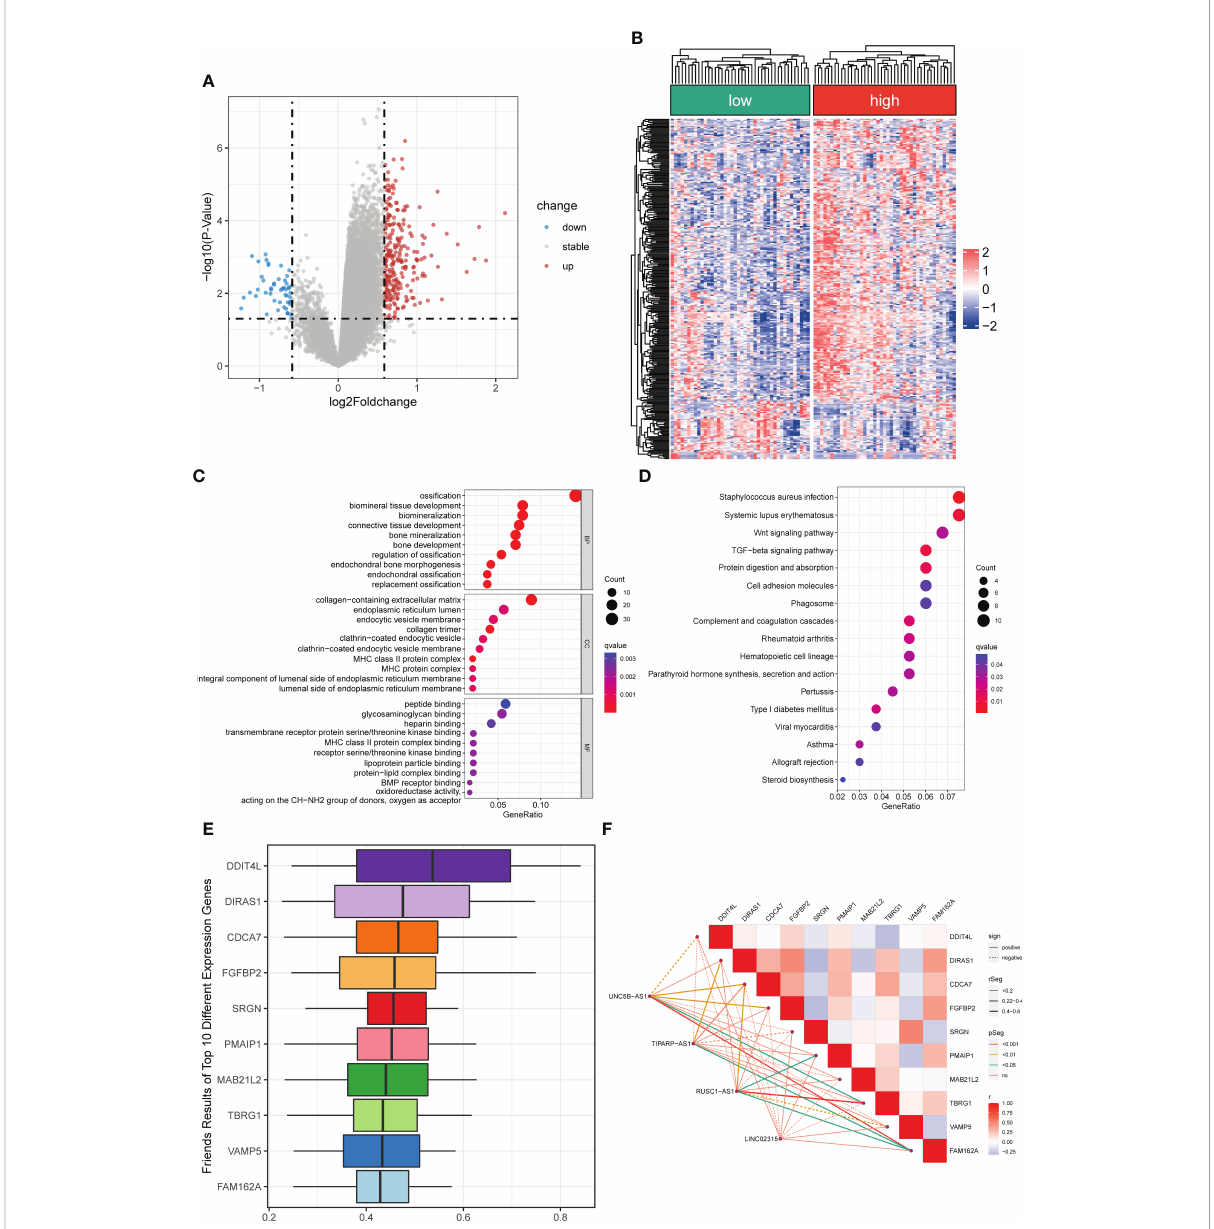
FIGURE 5 Differentially expressed and functional enrichment analysis between distinct risk groups. (A, B) The volcano plot and heatmap of differentially expressed genes between the low- and high-risk groups. (C, D) The GO analysis and KEGG enrichment pathway analysis between different risk groups. (E) The Friends analysis of GO-related genes. (F) The association between these ten hub genes and four signature